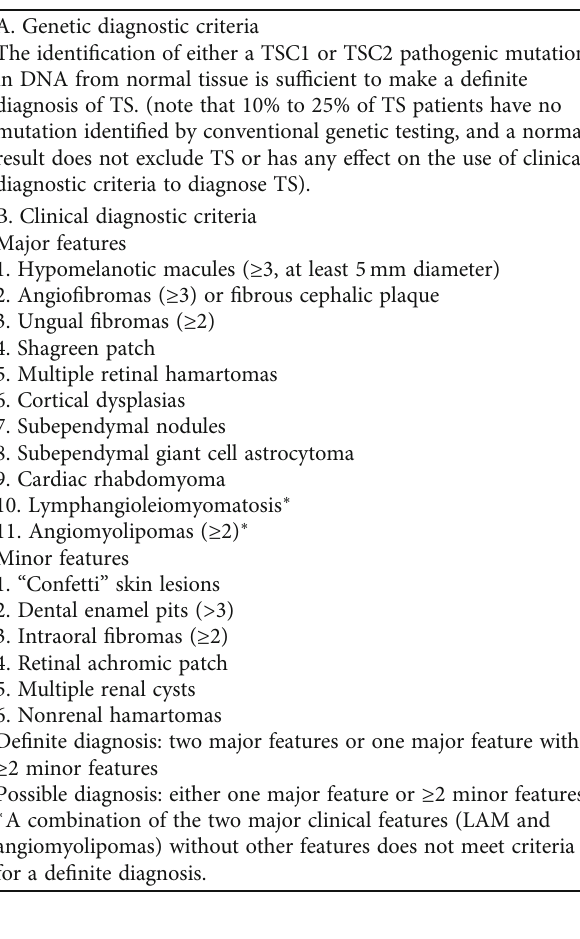
Table 1: Updated diagnostic criteria for tuberous sclerosis complex 2012 (reproduced from Northrup and Krueger